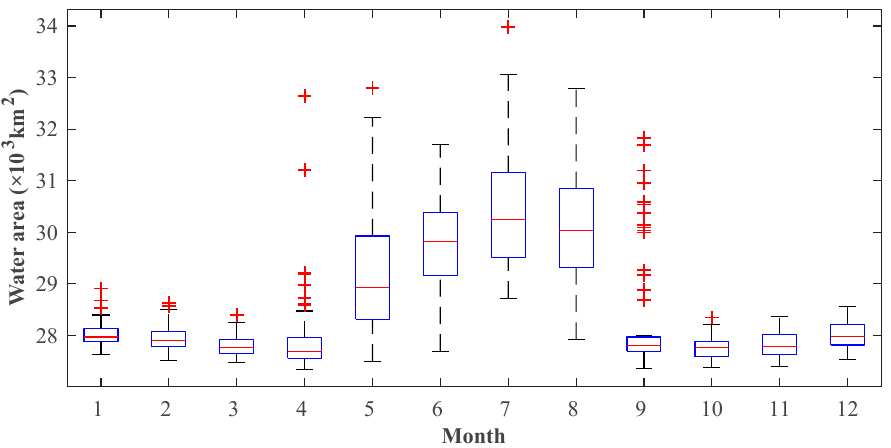
Figure 13. Change in surface water for 1–12 months in YRB. ‘+’ denotes the anomaly values for this month.